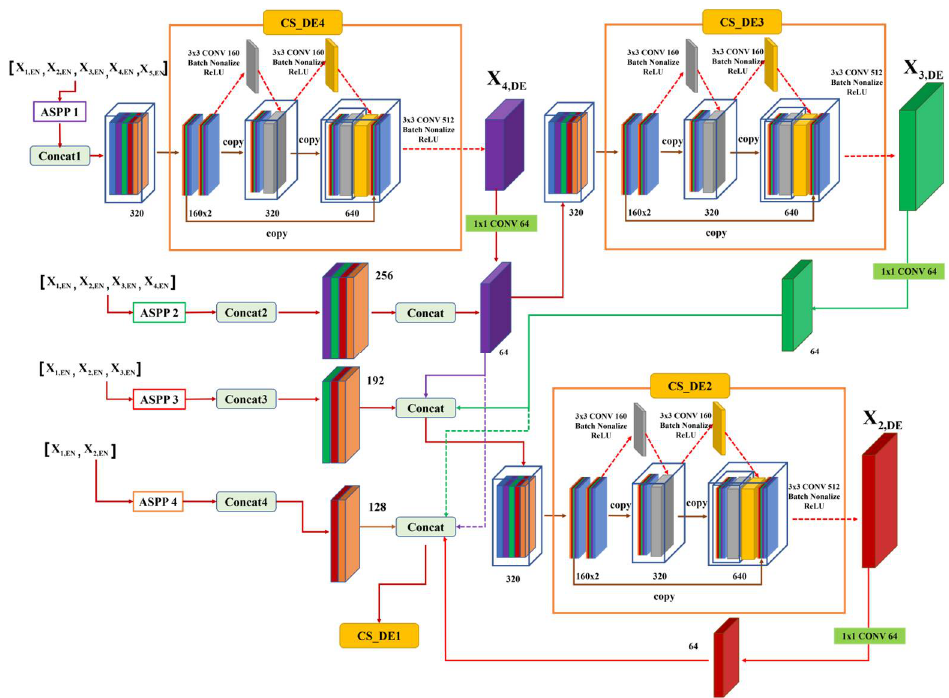
Figure 13. Structure of the decoder cross-stage